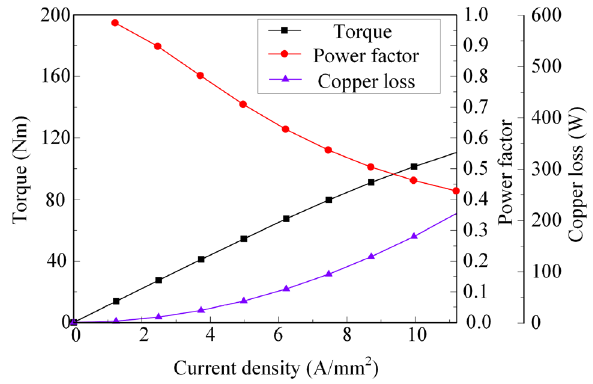
Figure 8. Electromagnetic torque, power factor, copper loss vs current density.